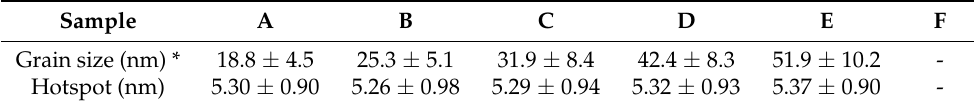
Figure 4. The grain sizes of Samples ( A – E ) are nearly Gaussian distributions.